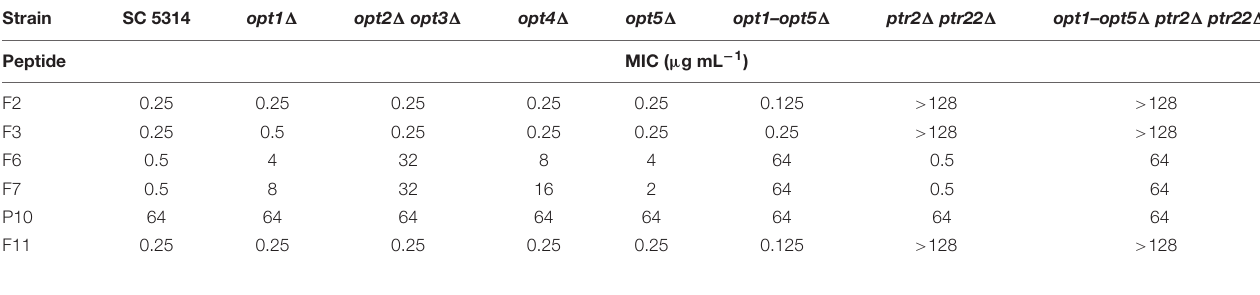
TABLE 4 | Growth inhibitory in vitro activity of FMDP-oligopeptides against C. albicans wild type cells and oligopeptide transporters-deficient mutants determined in YNB-AS medium. Strain